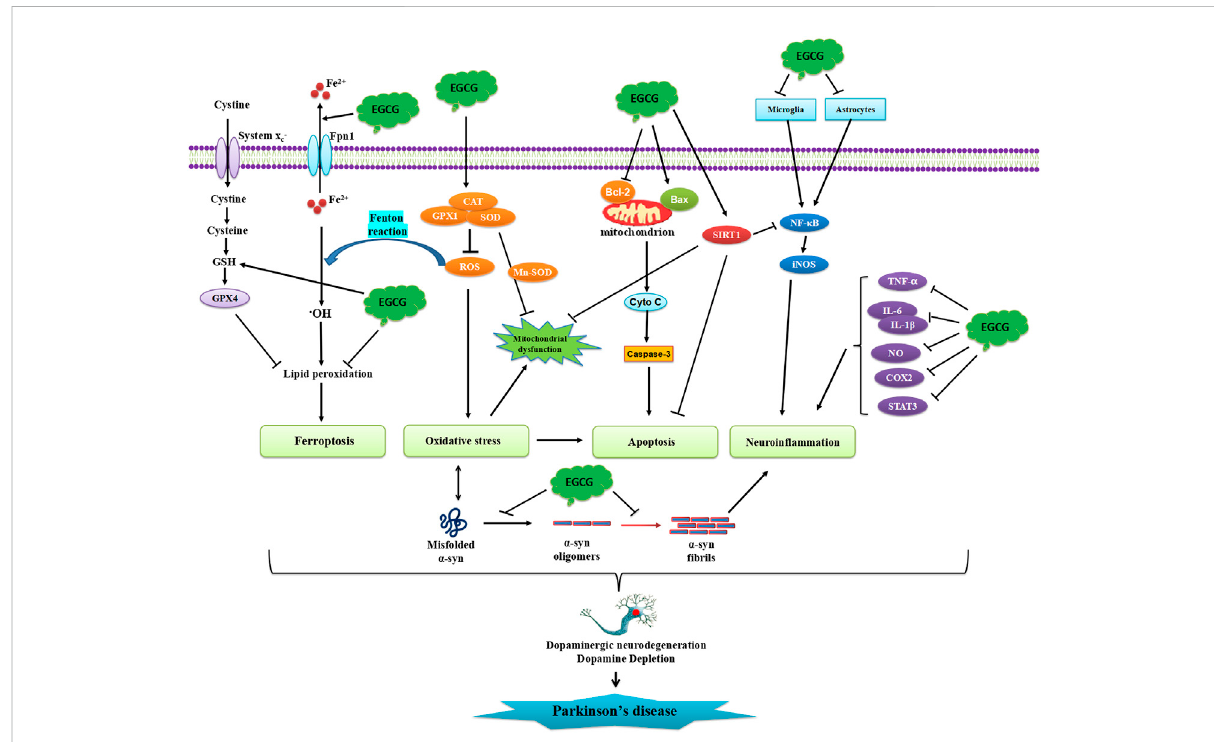
FIGURE 4 SchematicillustrationofneuroprotectiveeffectsofEGCGinPD.EGCGcanattenuate α -synucleinaggregation,oligomerization,and fi brillation. EGCG can also inhibit protein misfolding, oxidative stress, neuronal apoptosis, and neuroin fl ammatory